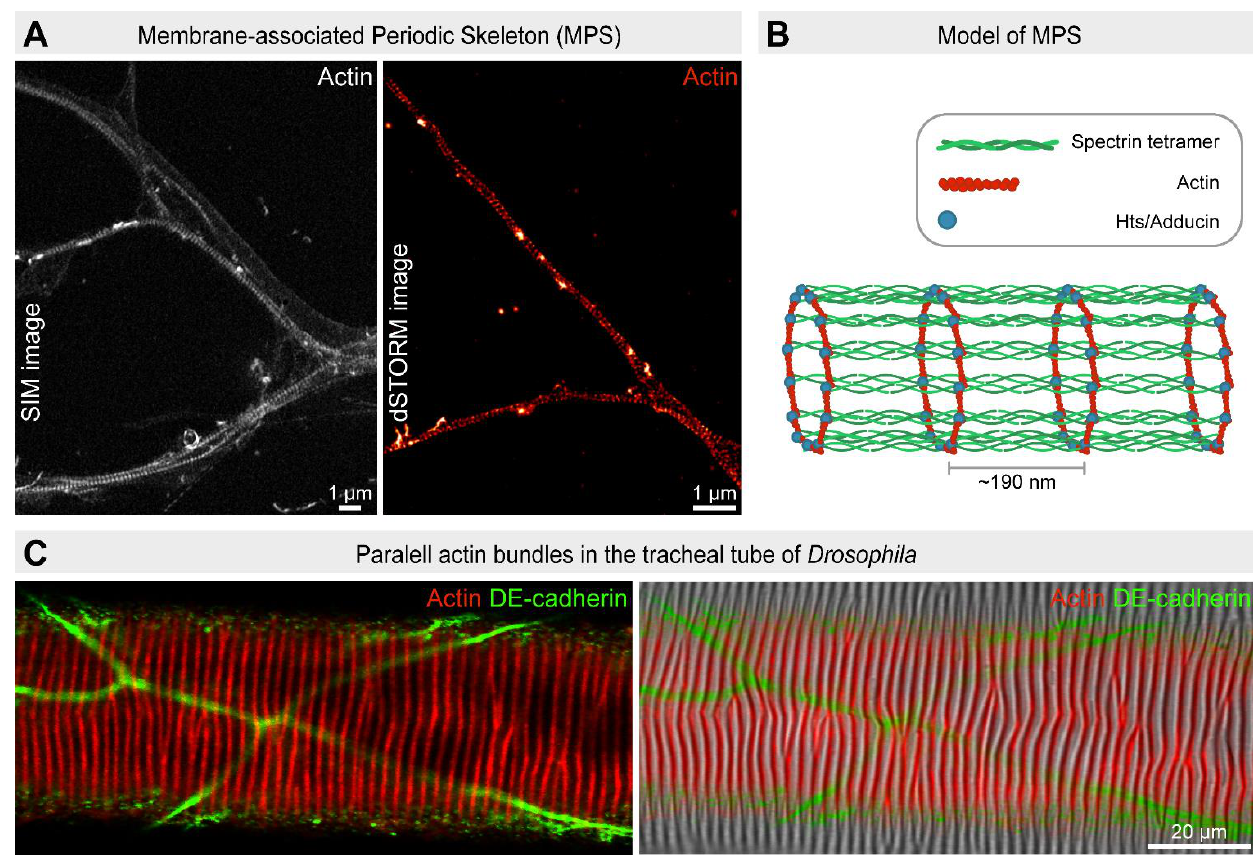
Figure 6. Structure and organization of the membrane-associated periodic actin skeleton. ( A ) Periodic actin rings revealed by SIM and dSTORM microscopy in Drosophila primary neuronal cell cultures (12 days in vitro). F-actin is labeled with phalloidin. Scale bar: 1 µm. ( B ) Model depicts the axonal actin rings composed of hts/adducin-capped short actin filaments evenly spaced by spectrin tetramers with a periodicity of ~190 nm. ( C ) Confocal image of a wild-type larval tracheal tube where actin (in red) is organized into parallel running bundles that are perpendicular to the tube axis. The number and phasing of these actin bundles correspond to the taenidial fold pattern displayed on the tracheal cuticle (on the right). DE-cadherin (in green) labels the cell